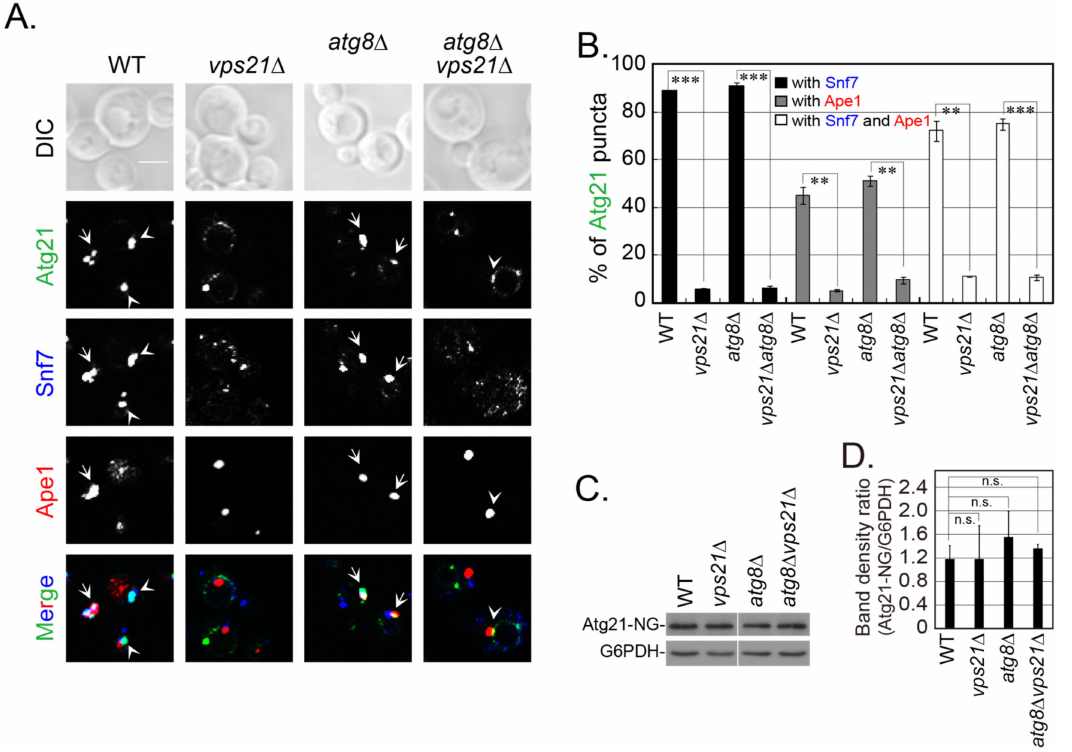
Figure 4. Atg21 localization to endosomes and/or the PAS decreases in vps21 ∆ cells, and both Atg21 and Snf7 are dispersed under nitrogen starvation. Cells were grown and treated as described in Figure 3. ( A ) Atg21-mNeonGreen mainly localized at Snf7-2xmTagBFP2-labeled endosomes, although it also showed partial localization to RFP-Ape1-labeled PAS/APs and also localized heavily to dots positive for both Snf7-2xmTagBFP2 and RFP-Ape1. All colocalizations were Vps21-dependent. The arrows indicate simultaneously colocalization of Atg21 at both endosomes and the PAS/APs, and the arrowheads indicate Atg21 localization to either endosomes or the PAS. Scale bar, 2 µ m. ( B ) Quantification of Atg21 at endosomes and/or the PAS/APs. The percentages of Atg21-positive puncta at Snf7-2xmTagBFP2-labeled endosomes and/or RFP-Ape1-labeled PAS/APs (panel A ) were quantified and are presented as the mean ± SD. ( C ) The protein expression levels of Atg21 in wild- type and vps21 ∆ cells were equal, regardless of whether ATG8 was deleted. An anti-mNeonGreen antibody was used to probe for Atg21-mNeonGreen (NG). G6PDH served as a loading control. ( D ) Quantification of the Atg21-mNeonGreen: G6PDH band-density ratios (panel C ). The data are presented as the mean ± SD. Panels ( B , D ): n.s., not significant, **, p < 0.01; ***, p <